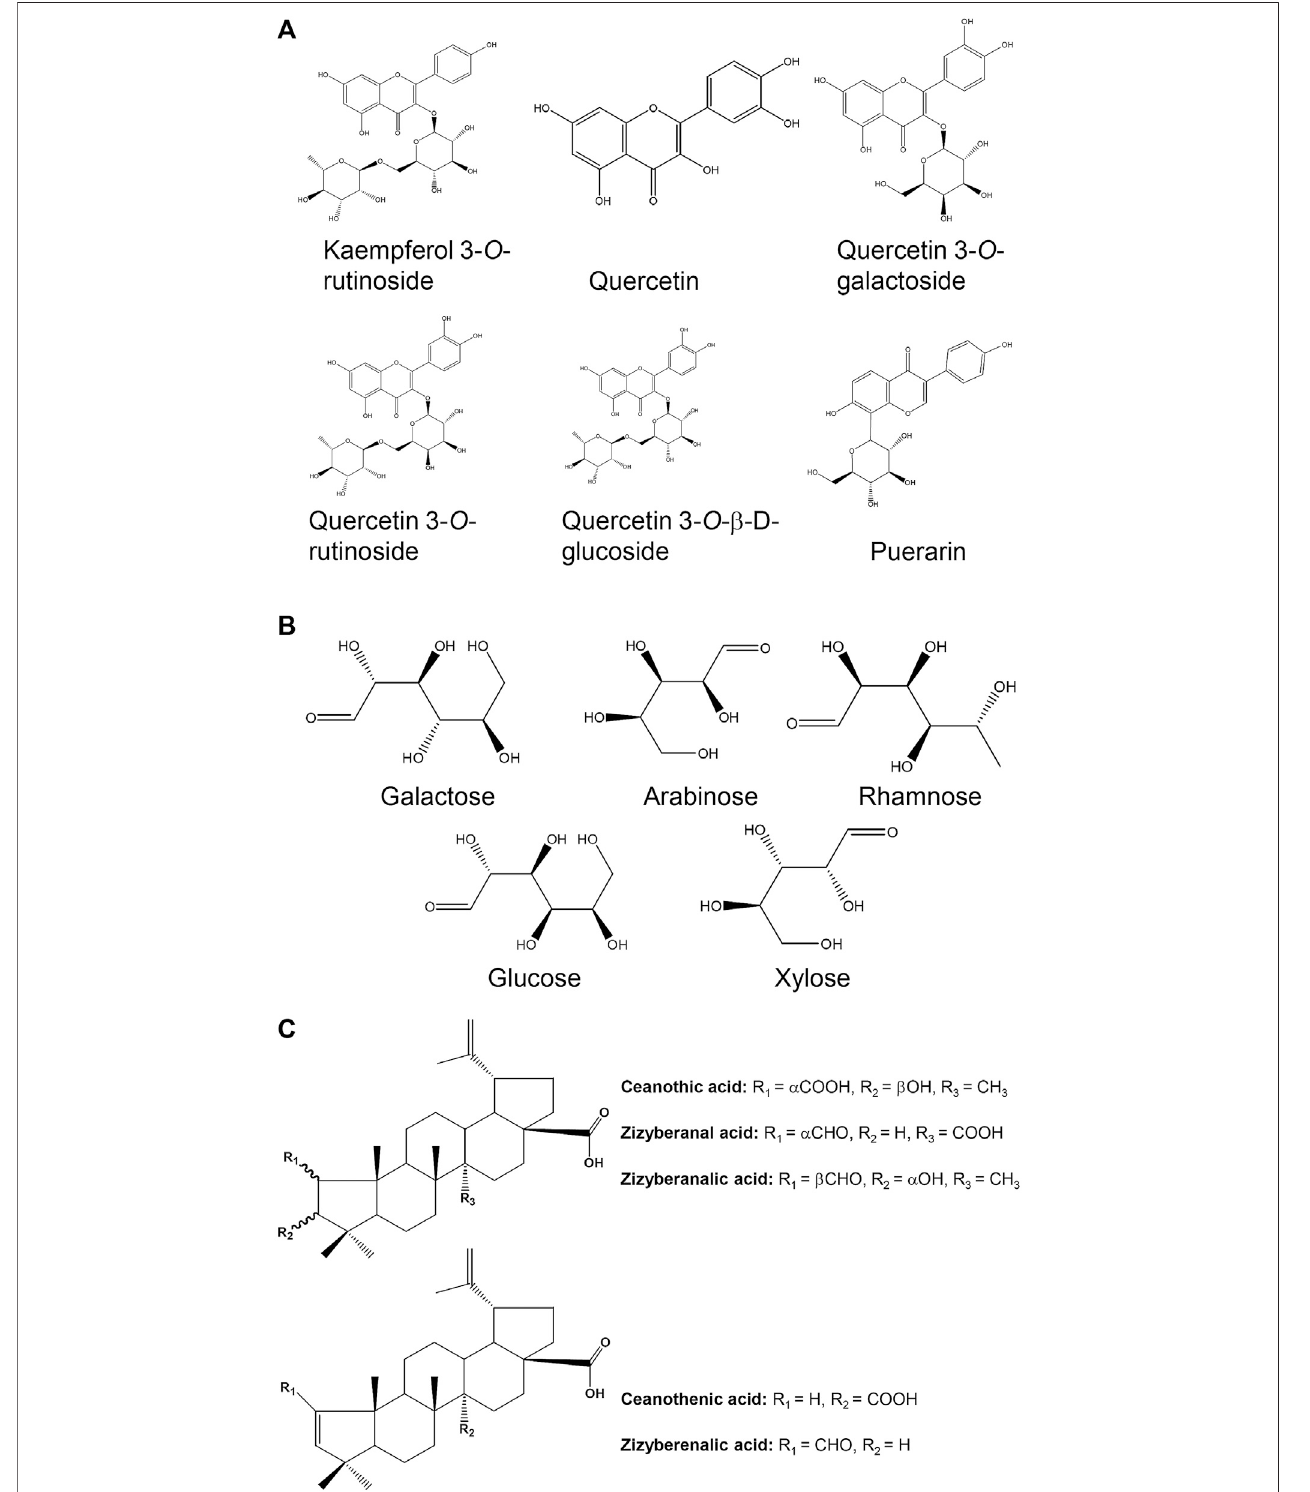
FIGURE 3 | Chemical structures for compounds in jujube possessing potential hematopoietic activity. (A) The chemical structures of six fl avonoids found in the fruits. (B) The composition in monosaccharide puri fi ed from jujube. (C) The chemical structures of varieties of triterpenic acids found in the fruit.